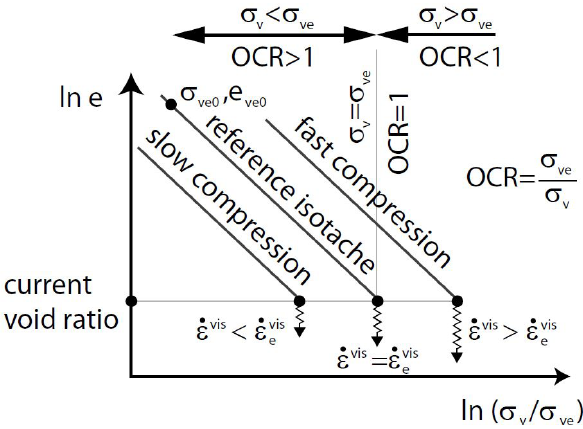
Figure 10: Isotaches